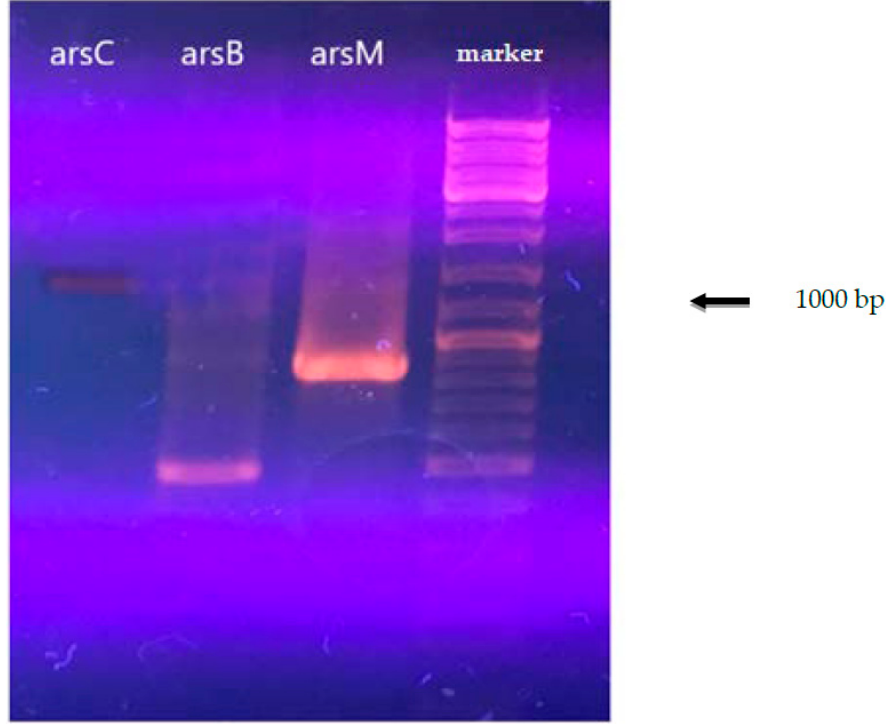
Figure 1. Electrophoresis of the PCR product of A. ferrooxidans total DNA with primers for the arsC , arsM , and arsB